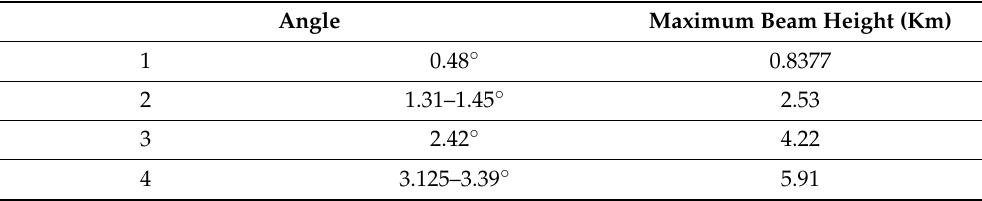
Figure 2. NEXRAD elevation angle scanning modes of operation for ( a ) seven elevations, ( b ) eight elevations and ( c ) nine elevations. Table 1. Elevation angles and their maximum beam heights. Table 1. Elevation angles and their maximum beam